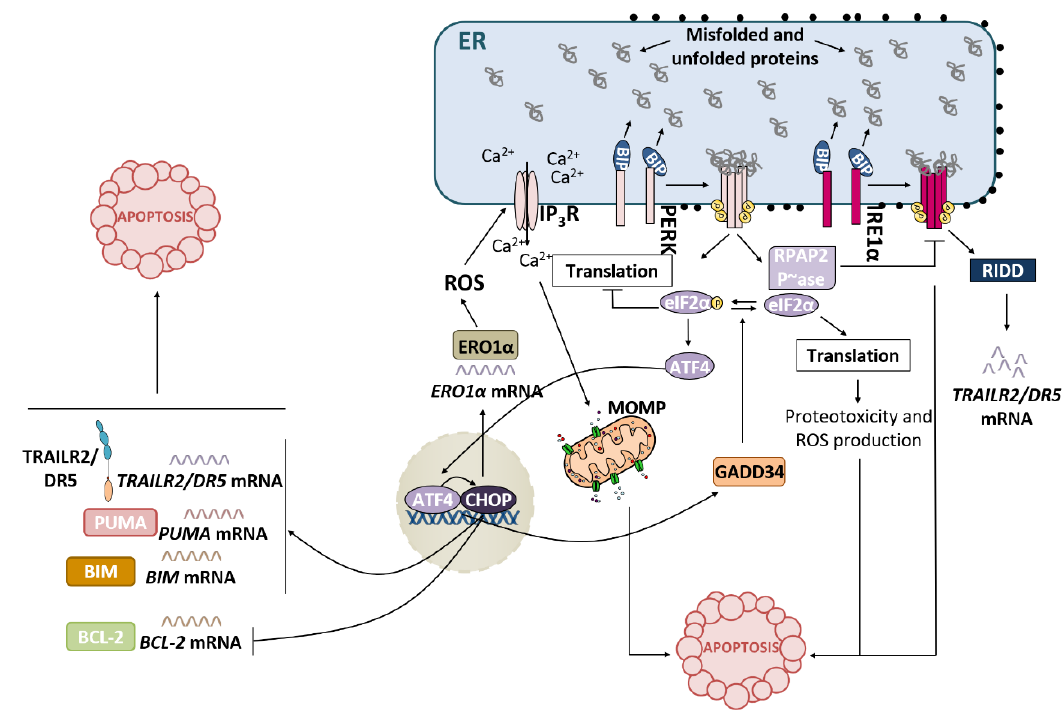
Figure 3. PERK pathway in apoptosis induction. Upon ER stress, PERK activation results in the inhibition of global protein synthesis. At the same time, translation of ATF4 transcription factor will in turn lead to induction of CHOP. ATF4/CHOP heterodimer will be responsible for the upregulation of different genes involved in the control of cell death by apoptosis.